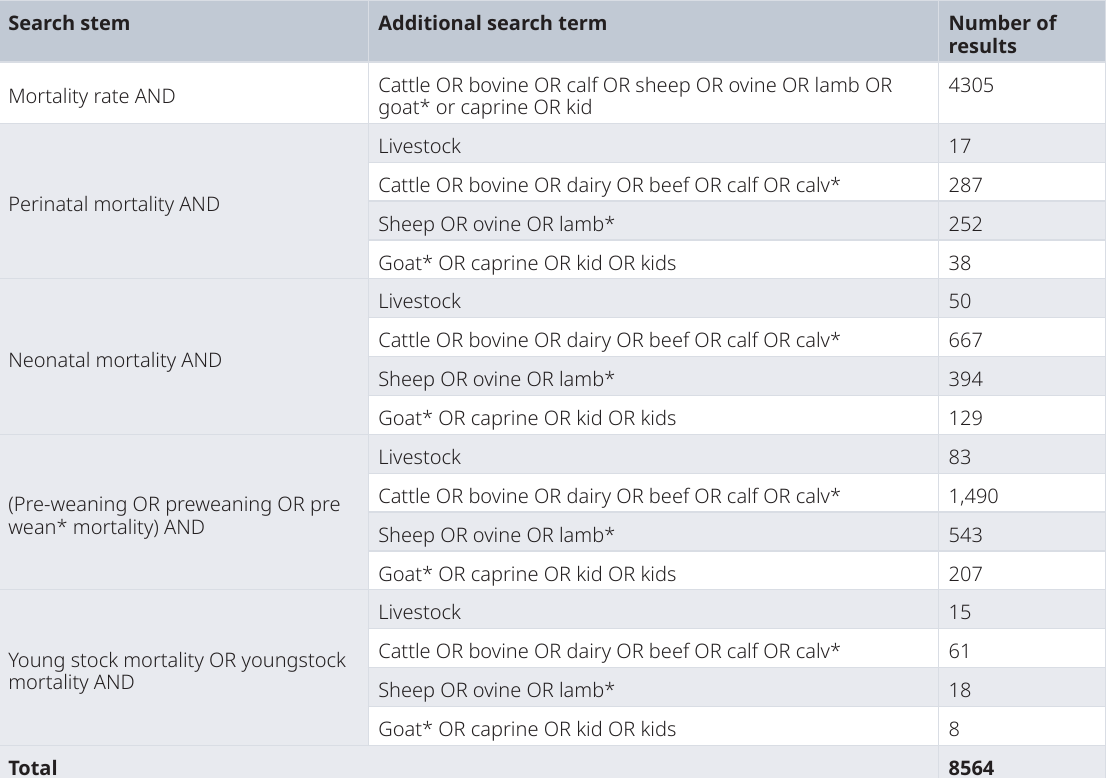
Table 3. Initial Web of Science search terms and results.